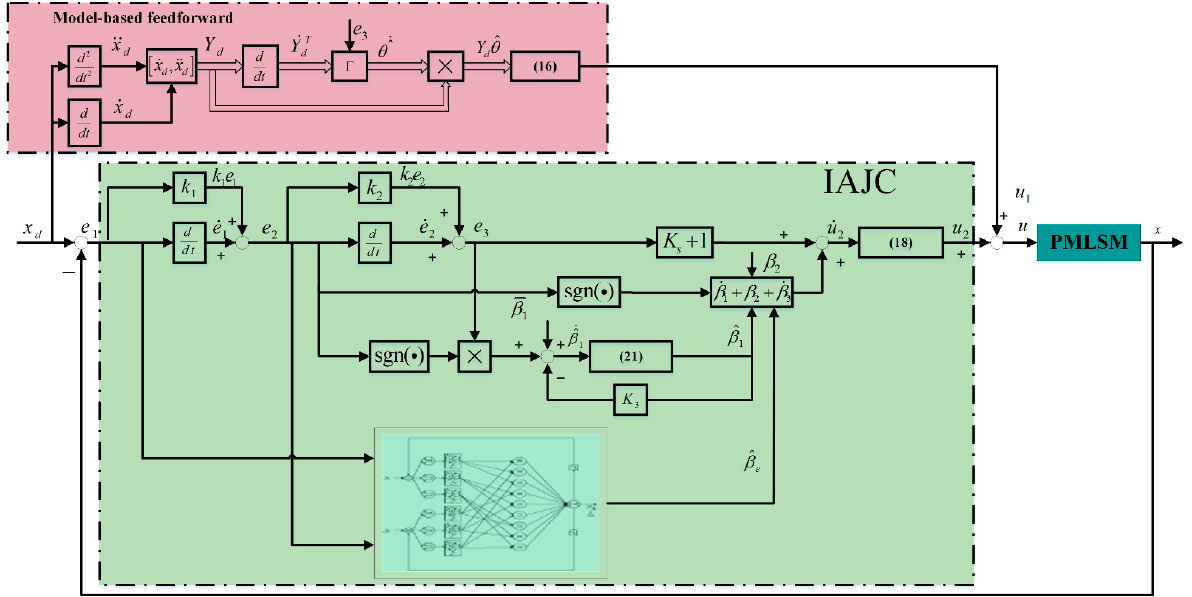
Figure 17. Control scheme for PMLSM servo system. Reprinted with permission from ref. [103]. Copyright 2020